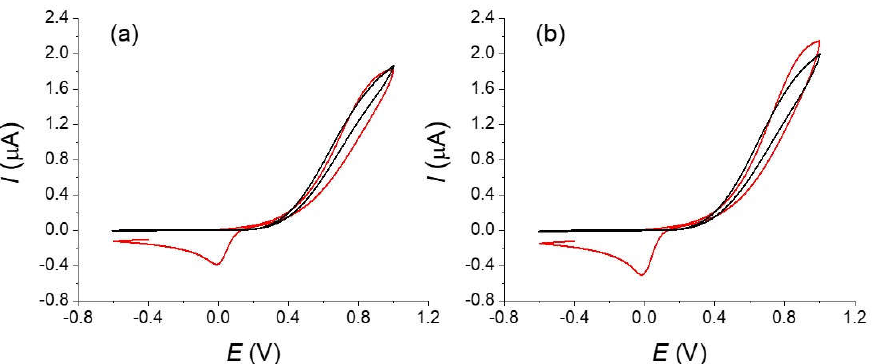
Figure 6. Simulation (in red) and experimental curves (in black) on the crude carbon fiber of a 10 −2 mol L −1 potassium ferrocyanide solution in 0.5 mol L −1 KCl water. Scan rate ( a ) 0.5, ( b ) 1 V s −1 . Parameters used for the simulation are r = 4.5 µm; l = 1.1 mm; α = 0.82, E° = 0.17 V, k s = 1.5 × 10 −4 s −1 . Black lines are the experimental curves. Red lines are the simulations.